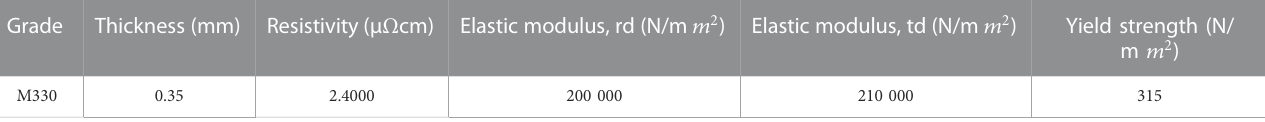
TABLE 3 Manufacturer-provided material data for M330-35A